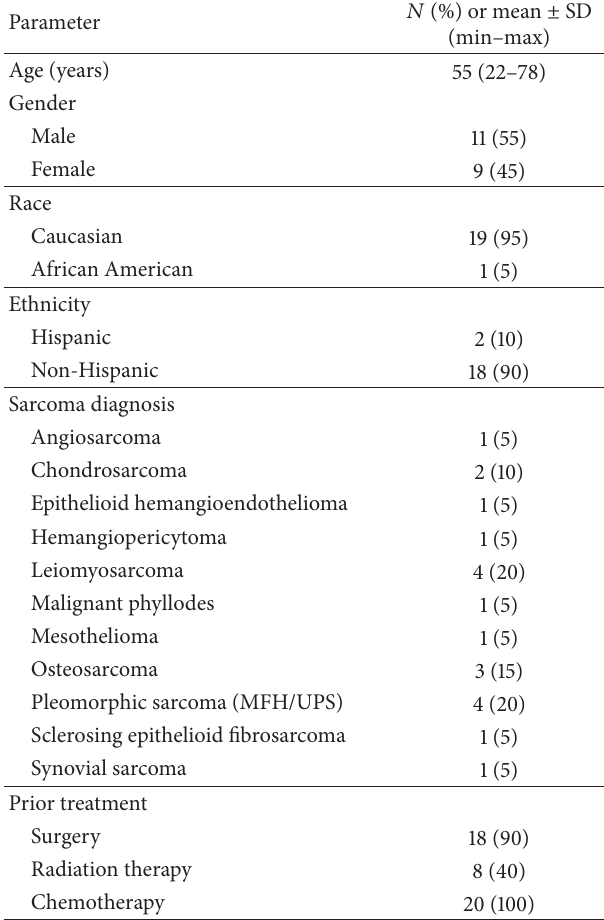
Table 1: Patient characteristics.